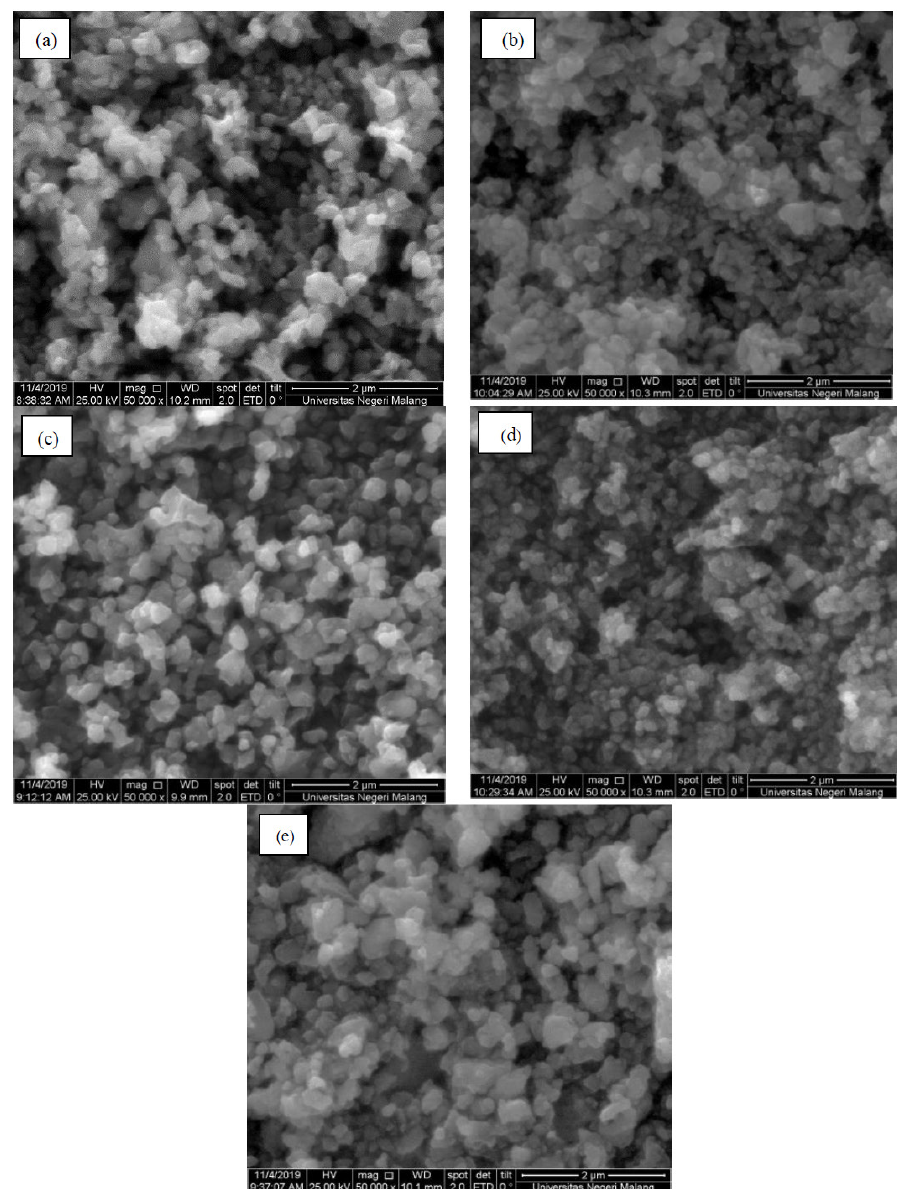
Figure 4. Morphology of Yttrium Iron Garnet with nickel a) Ni0.00, b) Ni0.02, c) Ni0.04, d) Ni0.06 and e) Ni0.08 in 50.000x